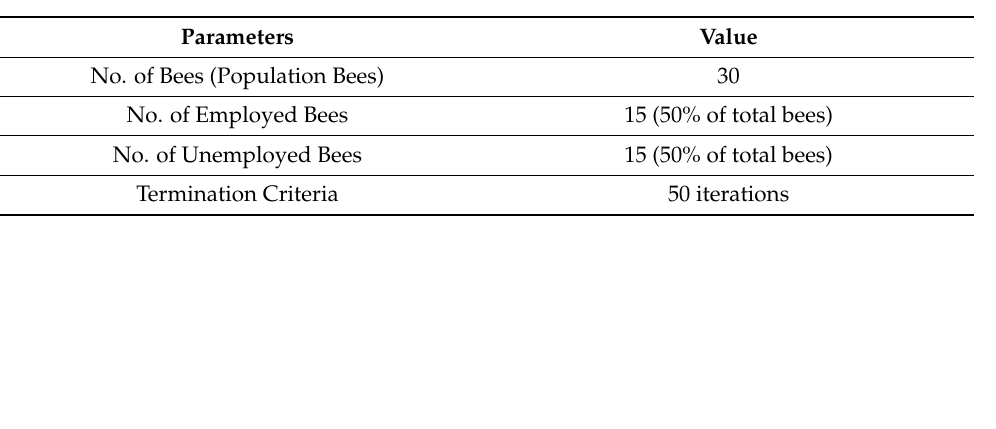
Table 7. Parameters of ABC